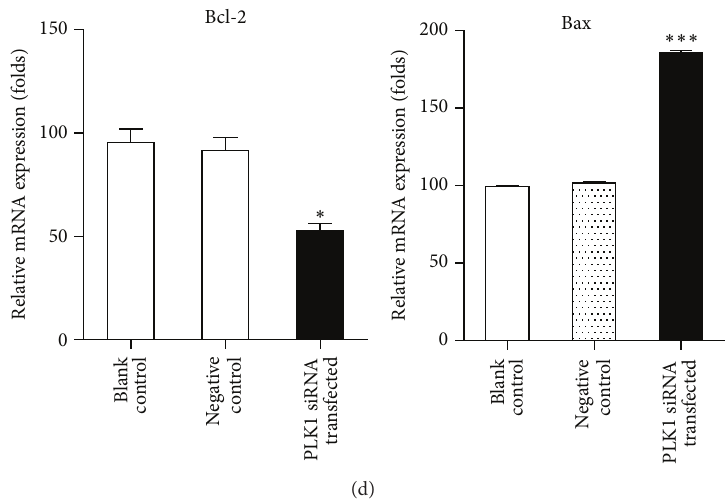
Figure 4: Knockdown of PLK1 in HCC accelerates cell apoptosis. BCL-7402 cells were transfected with PLK1 siRNA. 48 h later, (a) cells were harvested and subjected to annexin V and PI staining for apoptosis analysis by flow cytometry; (b) cells were observed using transmission electronic microscope (TEM); (c) cells were analyzed for caspase 3, caspase 8, and caspase 9 mRNA expression by real-time PCR; (d) cells were analyzed for Bcl-2 and Bax mRNA expression by real-time PCR. Results are shown as mean ± SD. Data are representative of at least 3 independent experiments. ∗ 𝑃 < 0.05 ; ∗∗∗ 𝑃 < 0.001